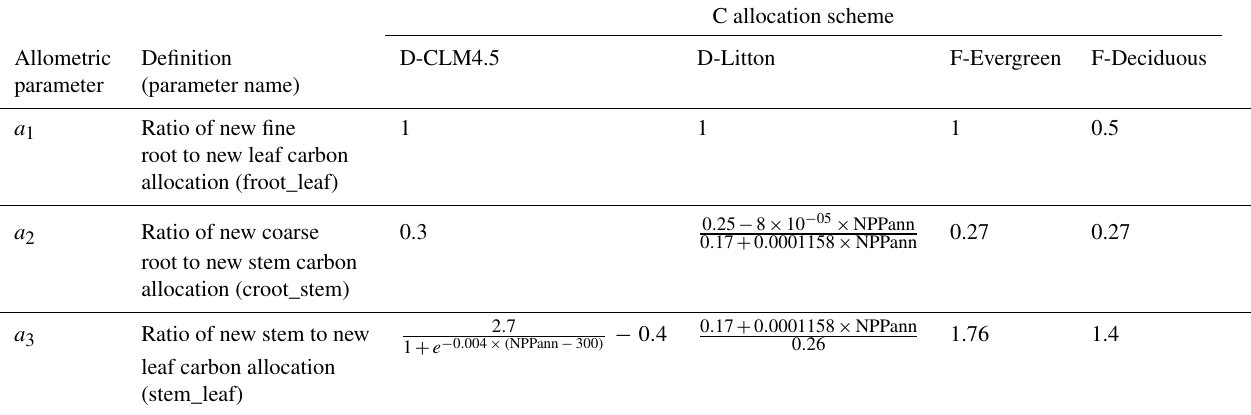
Table 2. Allometric parameter values for evergreen and deciduous temperate forests in the C allocation scheme in CLM described in Oleson et al. (2013; D-CLM4.5); the alternative dynamic C allocation scheme (D-Litton) based on Litton et al. (2007); and the 2 fixed C allocation schemes (F-Evergreen, and F-Deciduous) based on Luyssaert et al. (2007). Allometric parameters represented with numbers indicate constant parameters, whereas equations indicate dynamic parameters. In the equations, NPPann is the annual sum of net primary productivity (NPP) of the previous